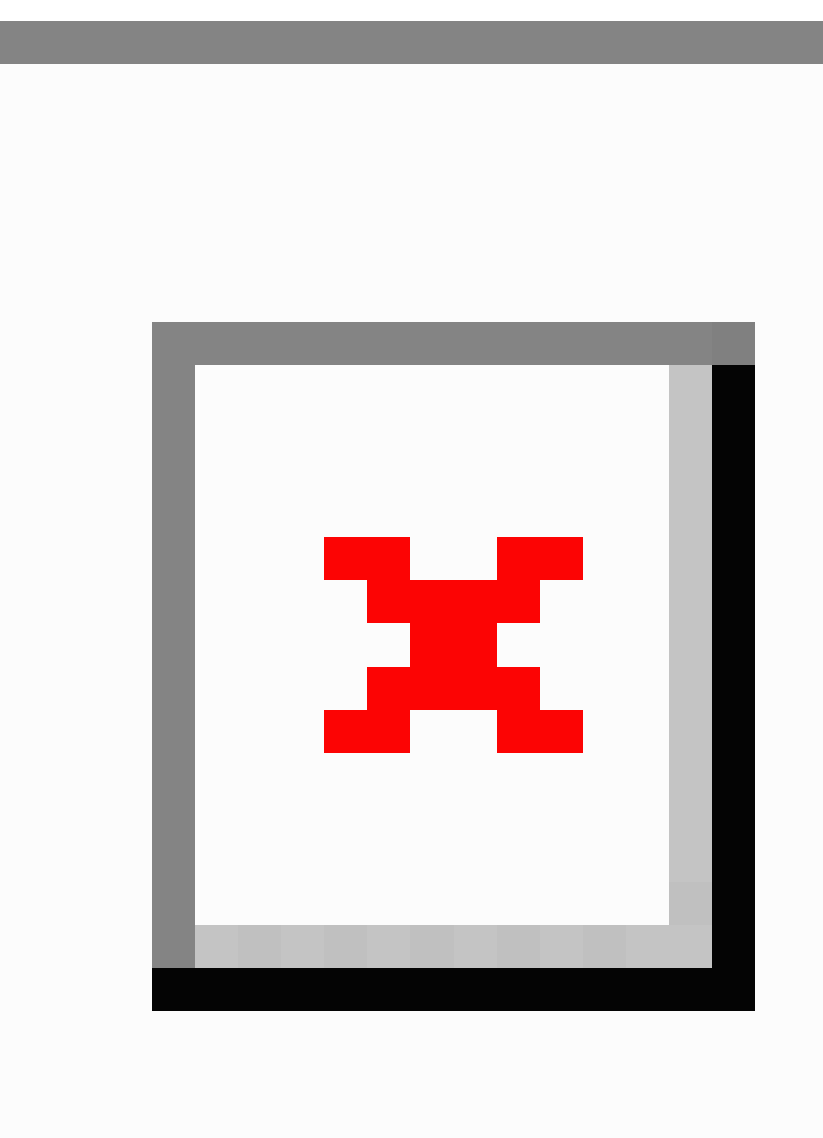
Figure 5. Screenshot of part of the ePOCS system Tracker, used to generate and send required daily patient correspondence (due invitations, reminders, etc, appear in